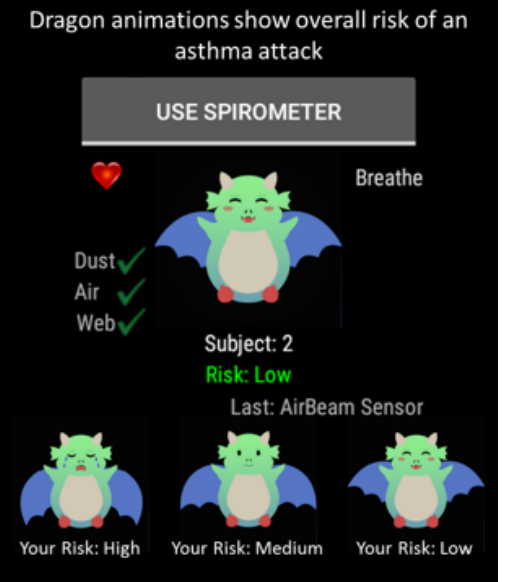
Figure 3. Asthma app user interface on the smartwatch. The dragons are animated, showing a happy bouncing dragon at a low asthma risk, a neutral face and slower bouncing dragon at a medium risk and a crying slow moving dragon at a high asthma attack risk